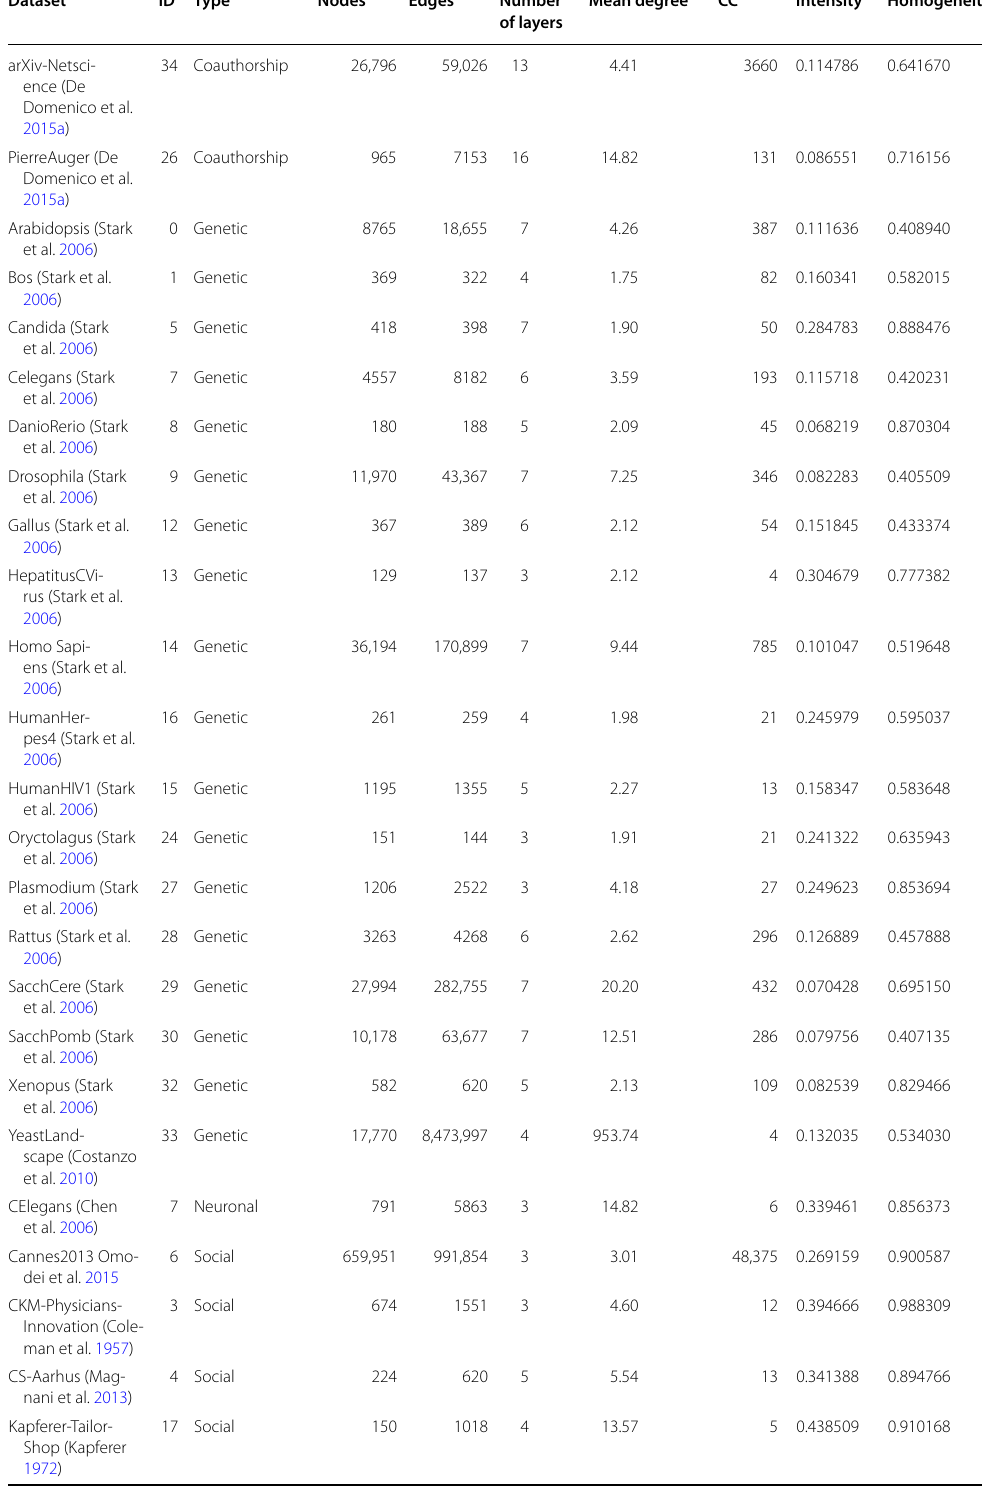
Table 1 Real multiplex networks and their